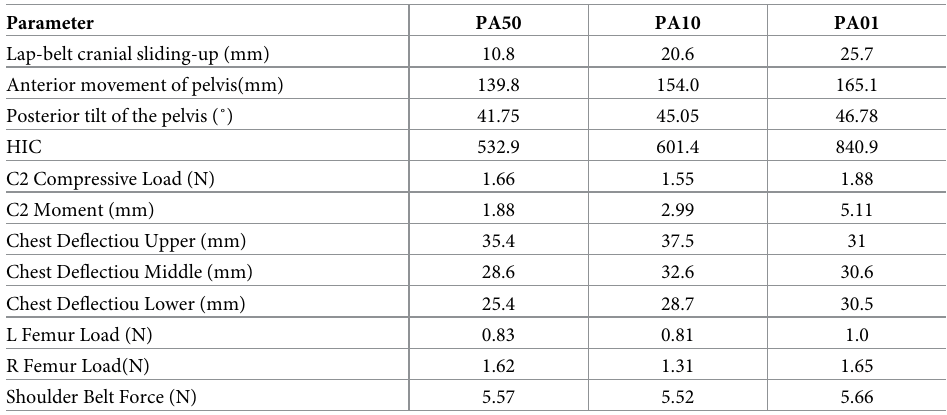
Table 1. Measured values for each